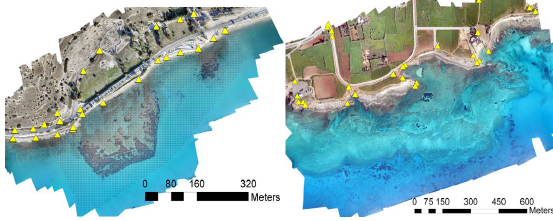
Figure 2. The two test sites. Amathouda (top) and Ag. Napa (bottom). Yellow triangles represent the GCPs